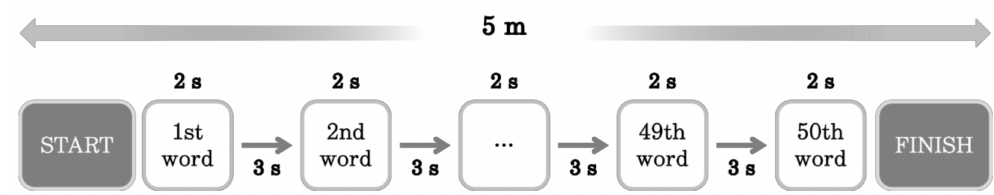
Figure 9. Process and duration of the speech intelligibility